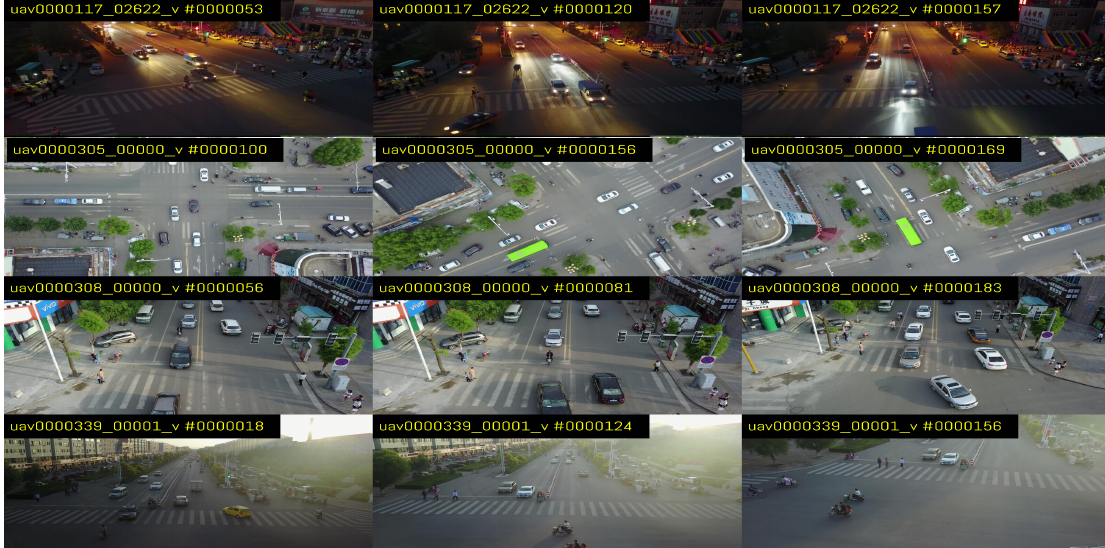
Figure 3. Some exemplary frames of videos in the VisDrone2019 dataset